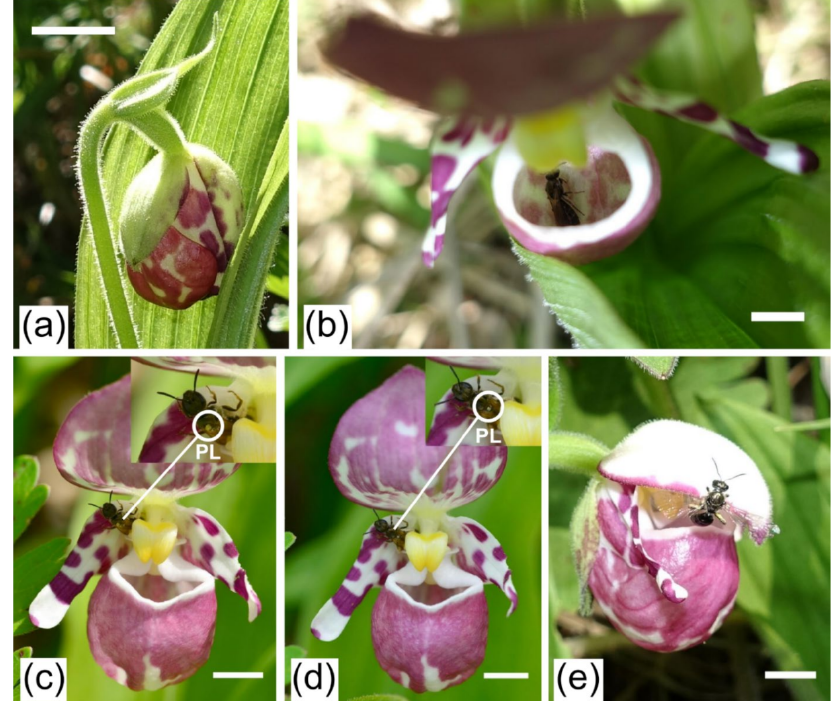
Figure 3. Flower and effective pollinators of Cypripedium guttatum ( a ). Large flower bud (scale bar = 10 mm). ( b ). A sweat bee ( Lasioglossum virideglaucum ) trapped in the flower (scale bar = 5 mm). ( c ), ( d ). When L. virideglaucum escaped the flower, its upper thorax was smeared with large (C) or small (D) pollen loads, which could be transported to the stigma of the other flowers (scale bar = 5 mm). ( e ). Lasioglossum miyabei escaped the flower by crawling along the upper surface of the sepal with no pollen load (PL = pollen load, scale bar = 5